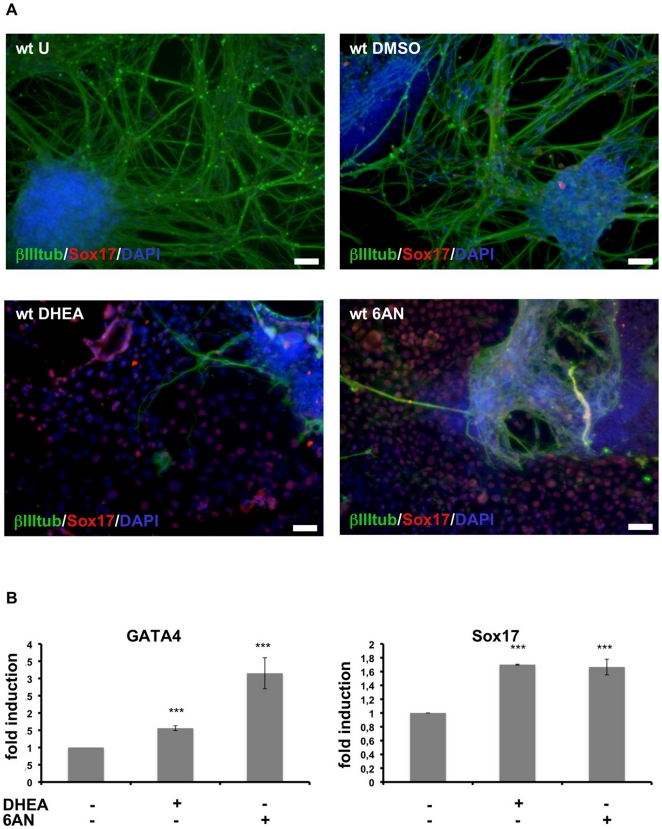
Inhibitors of the PPP induce endodermal differentiation.(A) Double immunostaining Sox17/βIII-tubulin/DAPI of cells at 10 days of differentiation showed areas of immunoreactive cells for Sox17 in wt ES cells differentiated in presence of DHEA or 6AN. Scale bars, 50 µm. (B) qRT-PCR for Sox17 and GATA4 in wt ES cells at day 10 after treatment with DHEA or 6AN during neural differentiation. Values are means ± SD (n = 3). *P<0.05; **P<0.01; ***P<0.001.